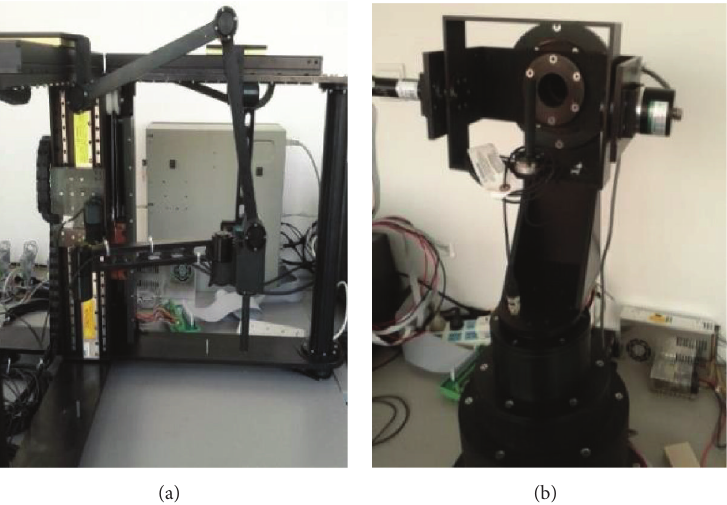
Figure 5: Translational platform and rotational platform.